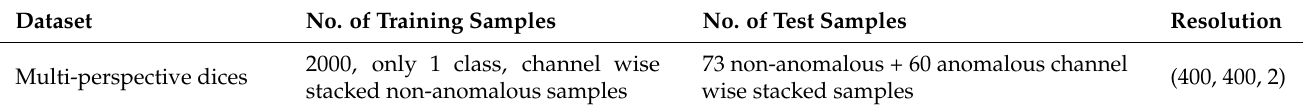
Table 1. Overview of our dices dataset [35].